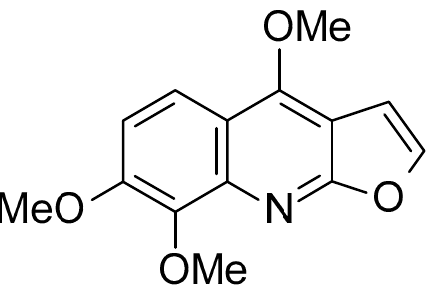
Figure 1. Structure of skimmianine.